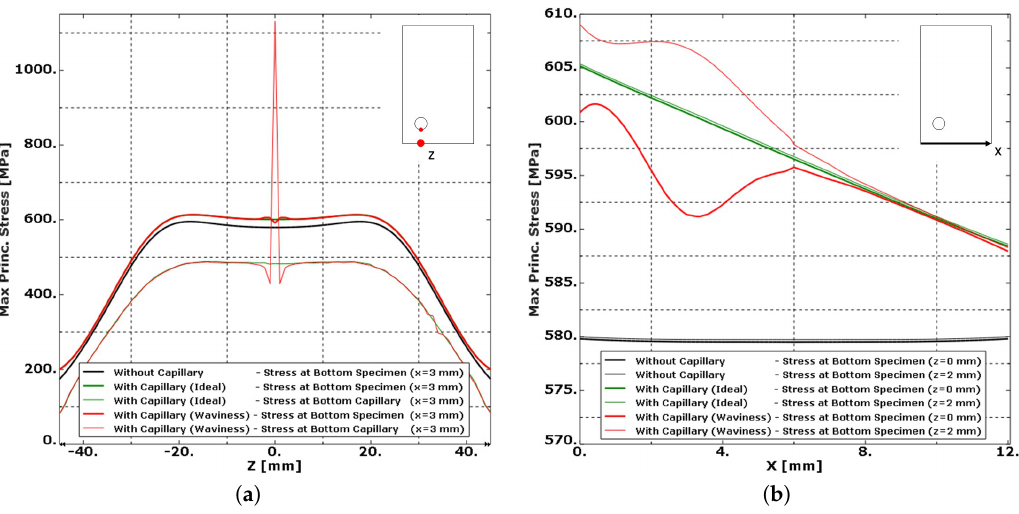
Figure 14. The stress level is plotted in a function of ( a ) the longitudinal Z-direction at the bottom of the specimen and bottom of the capillary and ( b ) at the bottom of the specimen along the X-direction for z = 0 mm and z = 2 mm. The stress concentration caused by the roughness of the capillary surpasses all stress levels of the specimen with smooth capillaries. The capillary becomes the place were fatigue initiation can be